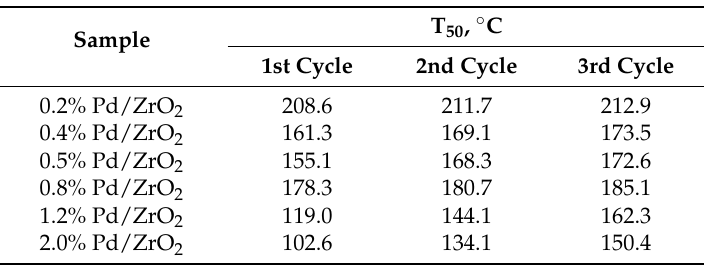
Figure 9. Light-off curves for the CO oxidation over 2% Pd/ZrO 2 catalyst in three consecutive catalytic cycles. Table 2. Temperature of 50% CO conversion for series of Pd/ZrO 2 catalysts in three consecutive catalytic cycles.